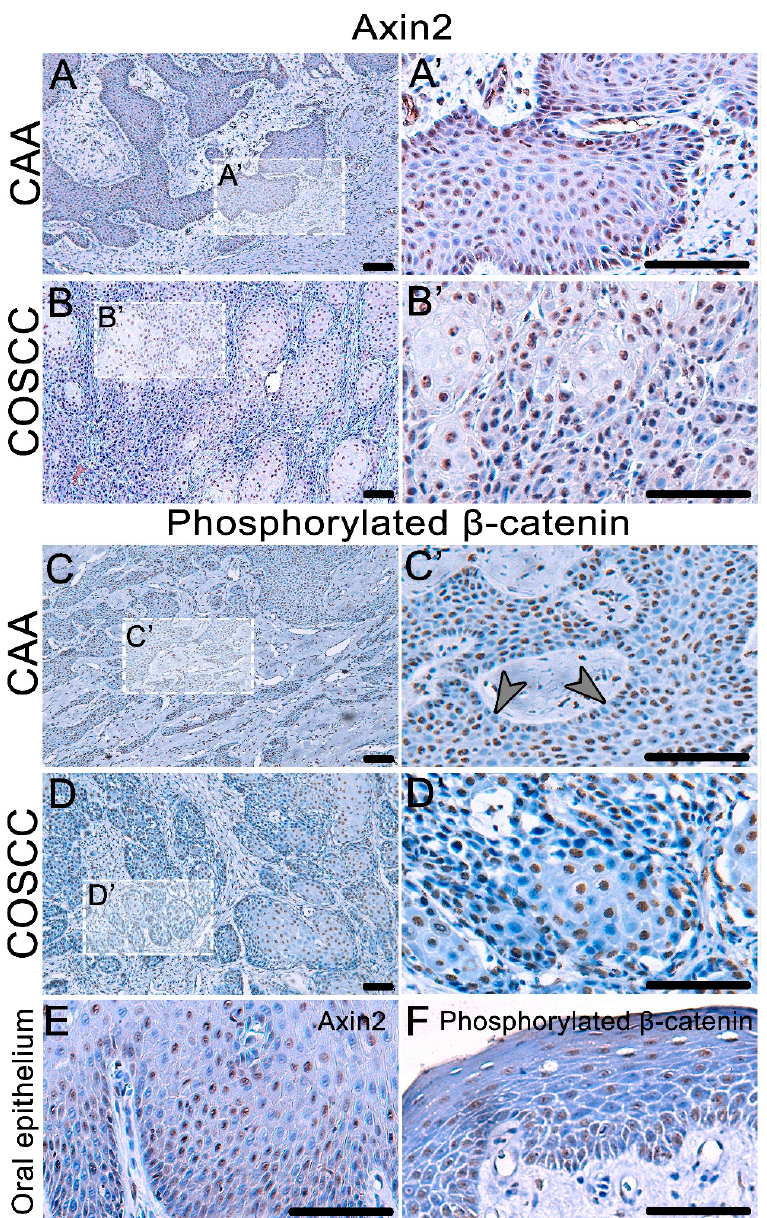
Figure 5. Detection of AXIN2 expression and β -catenin phosphorylated at Tyr 489 in COSCC and CAA. ( A,A´, B,B´ ) AXIN2 is overexpressed in the nuclei of both CAA and COCC. ( E ) The expression of AXIN2 in physiological canine oral epithelium is weak. ( C,D ) There is a strong nuclear expression of phosphorylated β -catenin in CAA and COSCC. ( C,C ´ ) In CAA, the signal is often weakened in the outer layer of the epithelial tumorous islets (arrowheads). ( D,D ´ ) There is a strong nuclear expression of phosphorylated β -catenin in COSCC, the signal is stronger in the larger and more differentiated cells in the middle of tumorous islets. ( F ) In the normal canine oral epithelium, the expression of phosphorylated β -catenin is very weak. Scale bar = 100 µ m. (A’–D’) Higher magnification